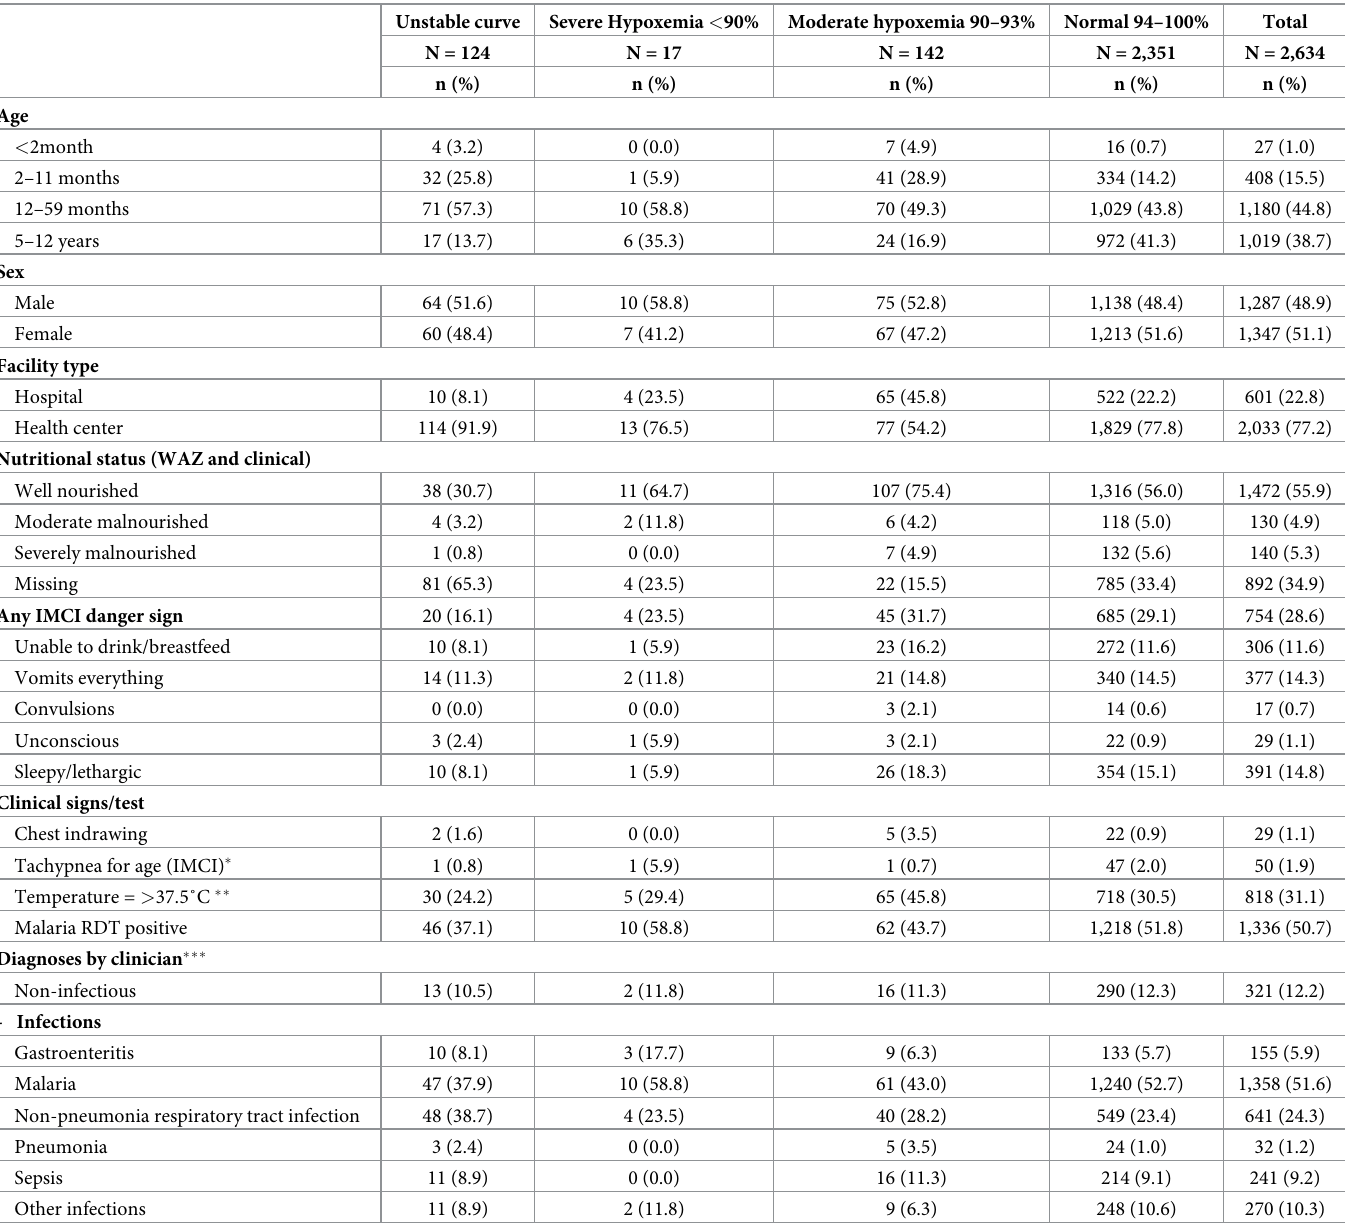
Table 3. Prevalence of oxygen saturation levels depending on background and clinical characteristics. Unstable